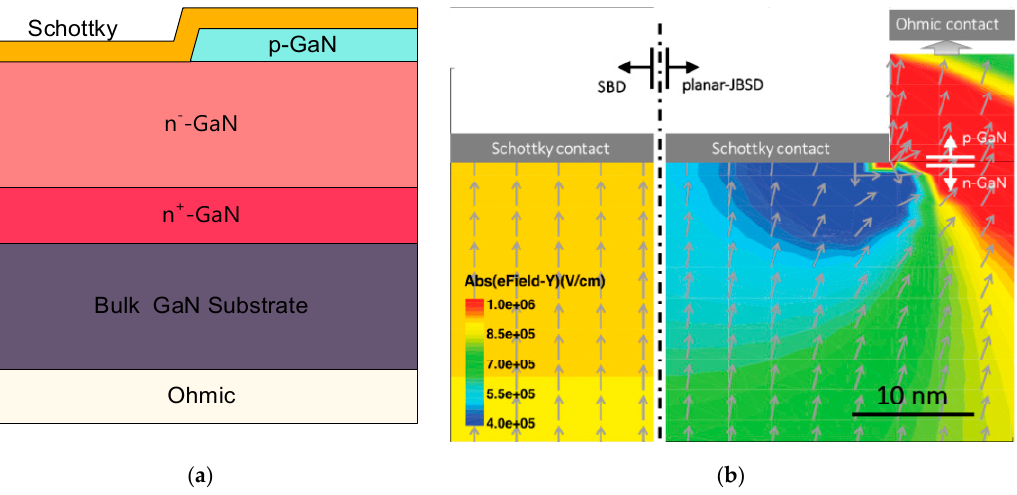
Figure 8. ( a ) Schematic cross-sections of GaN reduced surface field (RESURF) junction barrier-controlled Schottky (JBS) structure and ( b ) comparison of simulated E-field distribution of typical SBD with RESURF JBS at − 200 V.